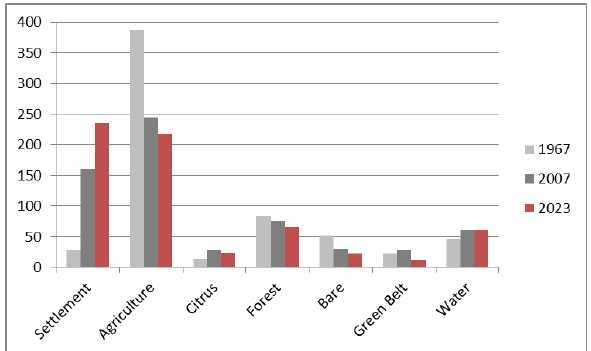
Figure 13. Area of change for 1967, 2007 and modeled 2023